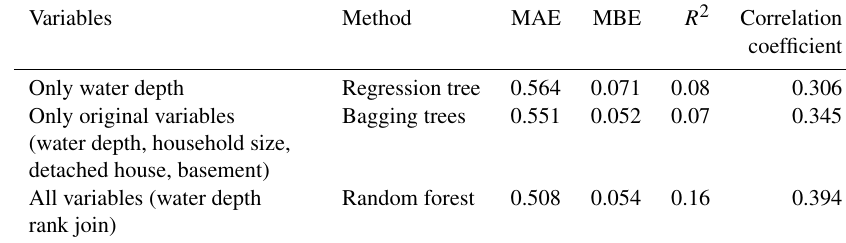
Table 3. The best-performing model based on the MAE indicator with different number of variables.